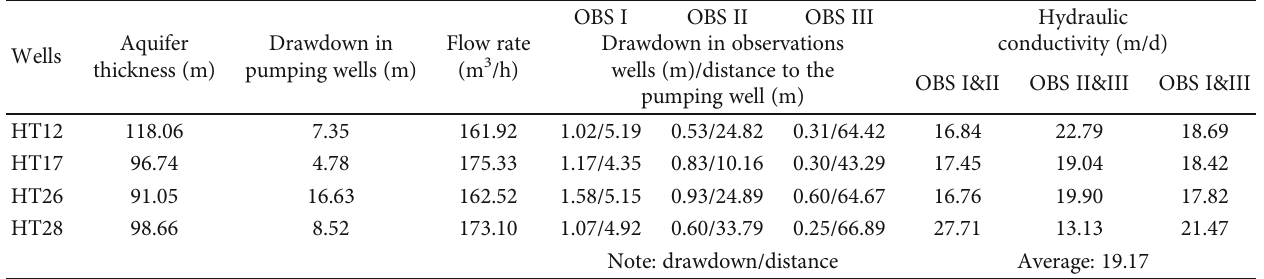
Table 3: Key results of single-well aquifer